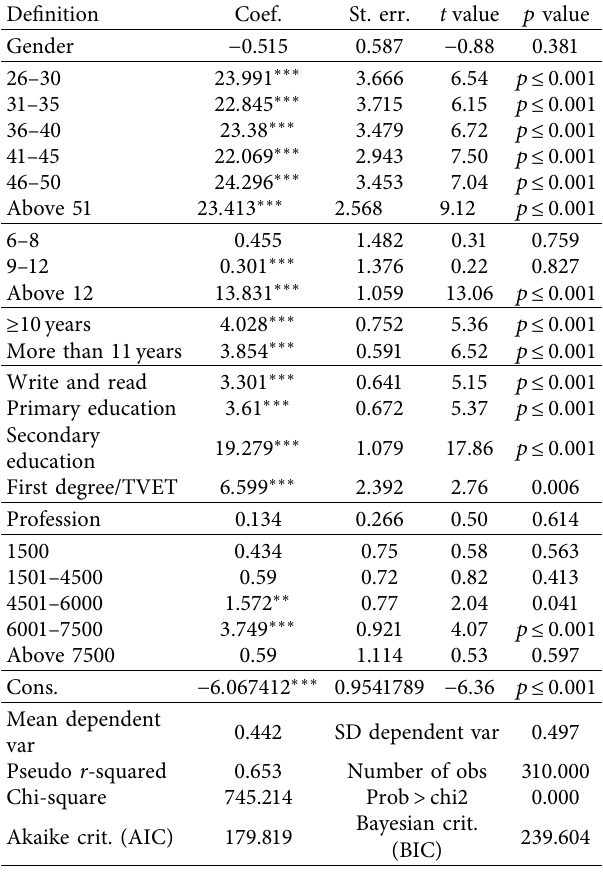
Table 3: Logistic regression model result (dependent variable biodiversity preferences